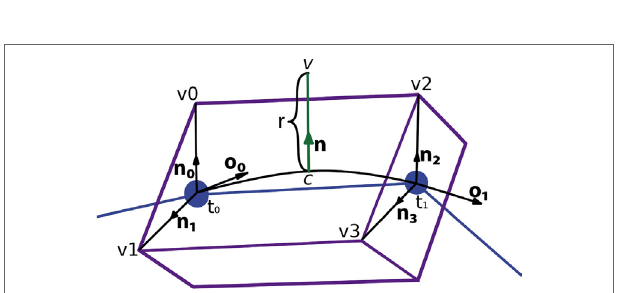
FIGURe 9 | Left image: resulting path when a fixed module for the orientation vectors is maintained. Right image: resulting path when an adaptive module is applied.